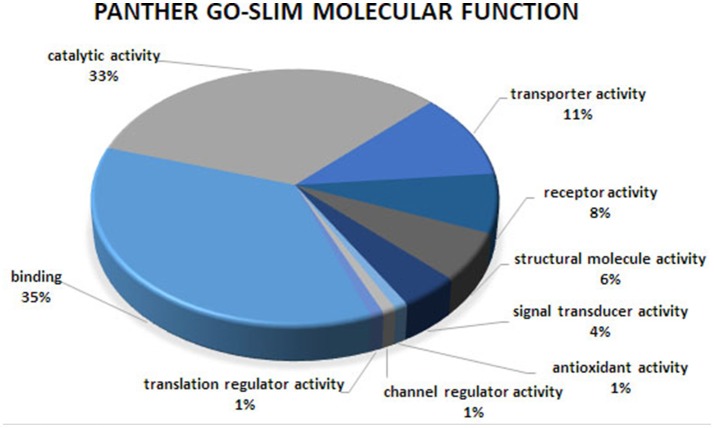
Molecular function analysis of the co-association network for meat quality complex. The PANTHER overrepresentation test grouped 609 annotated genes into 9 molecular function classes.